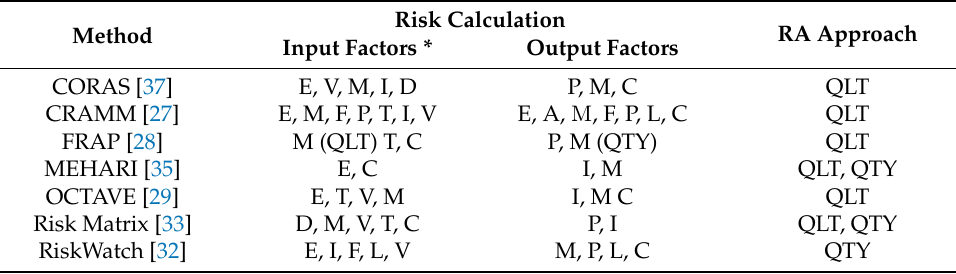
Table 2. Risk assessment methods and